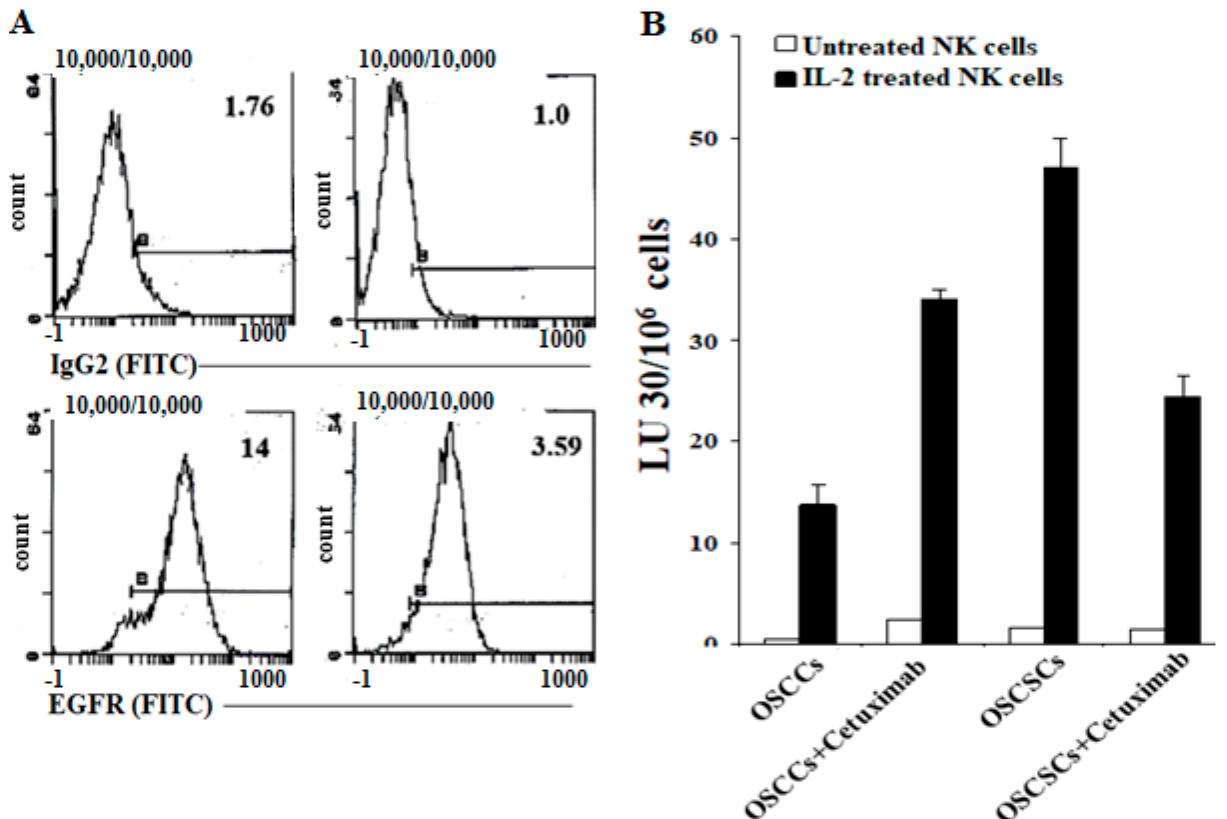
Figure 6. Higher levels of epidermal growth factor receptor (EGFR) surface expressions and NK cell-mediated ADCC in OSCCs in comparison to OSCSCs. The levels of EGFR expression were determined on OSCCs and OSCSCs using surface staining with Cetuximab ( A ). Numbers in the histograms represent mean fluorescence intensity (MFI). Purified NK cells (1 × 10 6 cells/mL) were left untreated or treated with IL-2 (1000 U/mL) for 18 h and used against untreated and Cetuximab-treated OSCCs and OSCSCs in a 4-h 51 Cr release assay. The lytic units (LU) 30/10 6 cells were determined using the inverse number of NK cells required to lyse 30% of target cells × 100 ( B ).